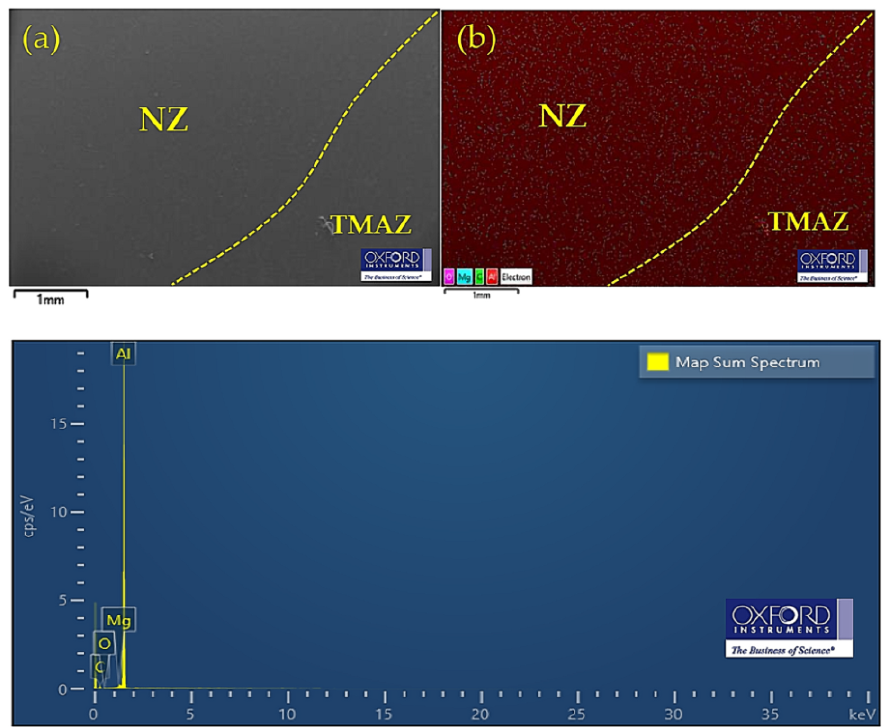
Figure 11. EDX mapping analysis of composition (wt%) in the NZ union of TMAZ: ( a ) SEM micrographs and ( b ) map showing color pattern analysis. Table 6. The composition percentage of NZ and TMAZ obtained from the FSSW process was measured via EDX mapping.